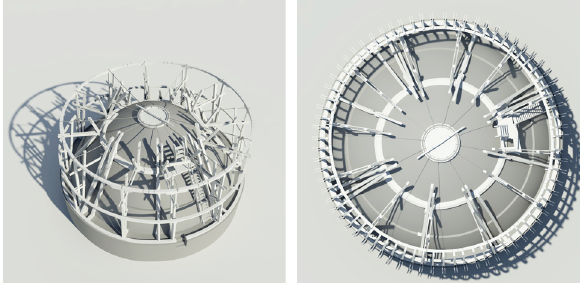
Figure 10. 3D digital representations made using